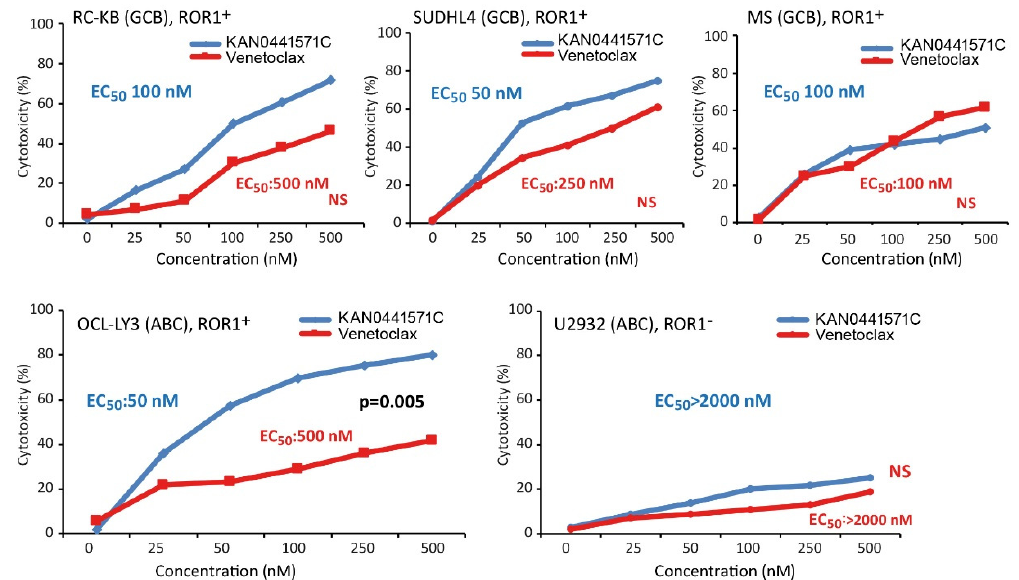
Figure 2. Cytotoxicity (MTT) of DLBCL cell lines of the GCB and ABC types incubated with KAN0441571C and venetoclax respectively for 48 h. EC 50 values for the respective drug are indicated as well as significant levels comparing KAN0441571C and venetoclax. All cell lines express phosphorylated ROR1 with the exception for U2932. For each concentration, six replicates were used and each experiment was carried out twice. NS: Not significant.